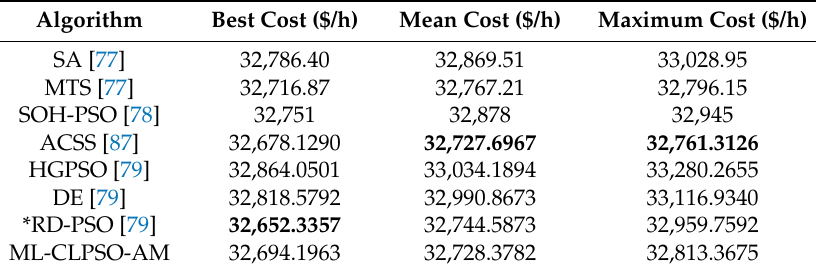
Table 9. Comparison test results on a 15-unit system.